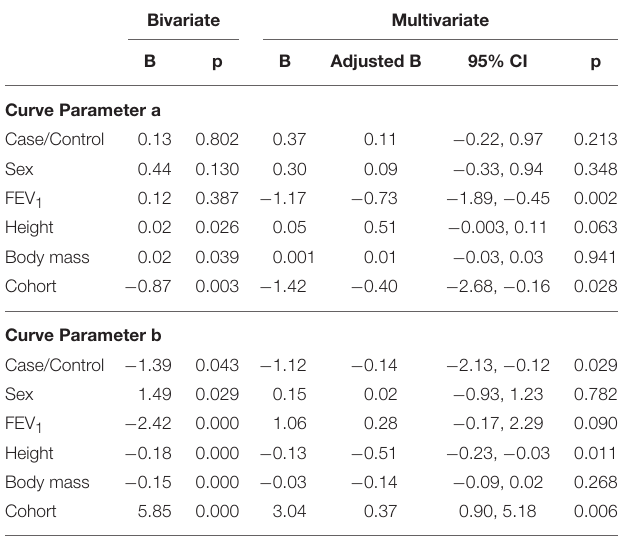
TABLE 5 | Multiple regression analyses for the curve parameters describing